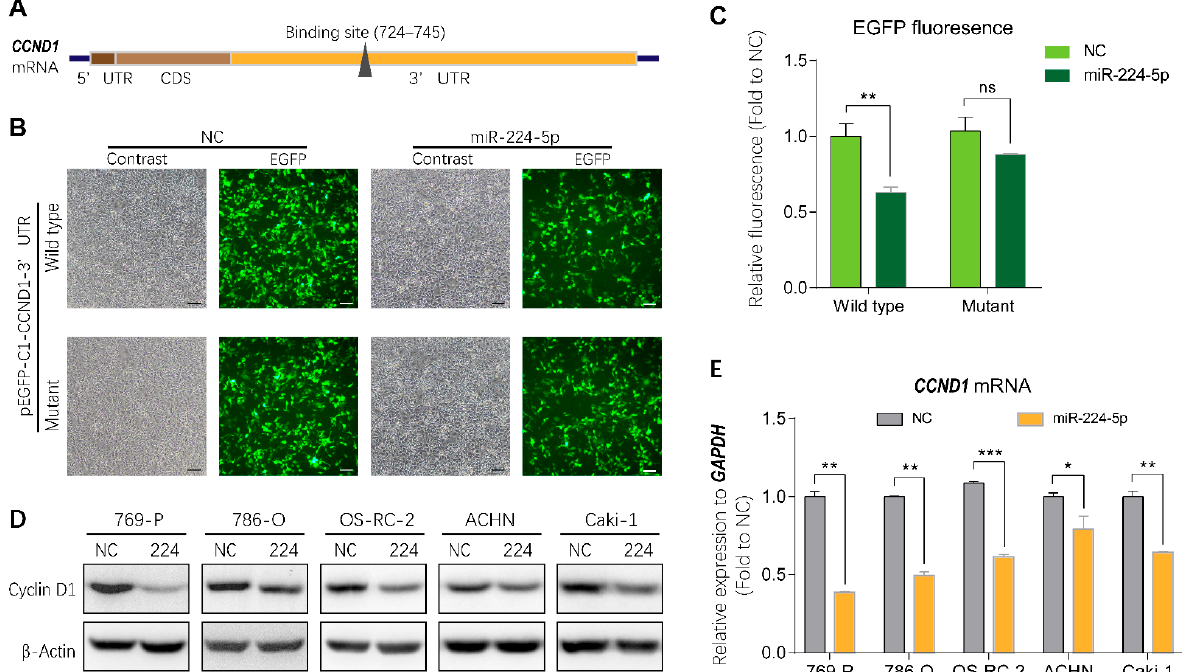
Figure 5. Cyclin D1 expression was regulated by miR-224-5p. ( A ) Schematic of potential binding sites of miR-224-5p in the 3 ′ UTR region of CCND1 mRNA. ( B , C ) GFP fluorescence in HEK293 cells after 48 h of co-transfection with indicated miRNA mimics (NC or miR-224-5p) and pEGFP-C1- CCND1 -3 ′ UTR wildtype/mutant plasmids. Scale bar, 100 nm. Fluorescent value of GFP (relative fluorescence) was normalized to concentration of total protein and shown as the fold of NC group. Data are mean ± s.e.m. ** p < 0.01; ns, no significant difference. ( D ) The regulation of cyclin D1 protein in RCC cells by miR-224-5p was determined by Western blot. ( E ) The regulation of CCND1 mRNA in RCC cells by miR-224-5p was determined by RT-qPCR. Data are mean ± s.e.m. * p < 0.05; ** p < 0.01; *** p < 0.001. (Original Western blots see Figure S7).